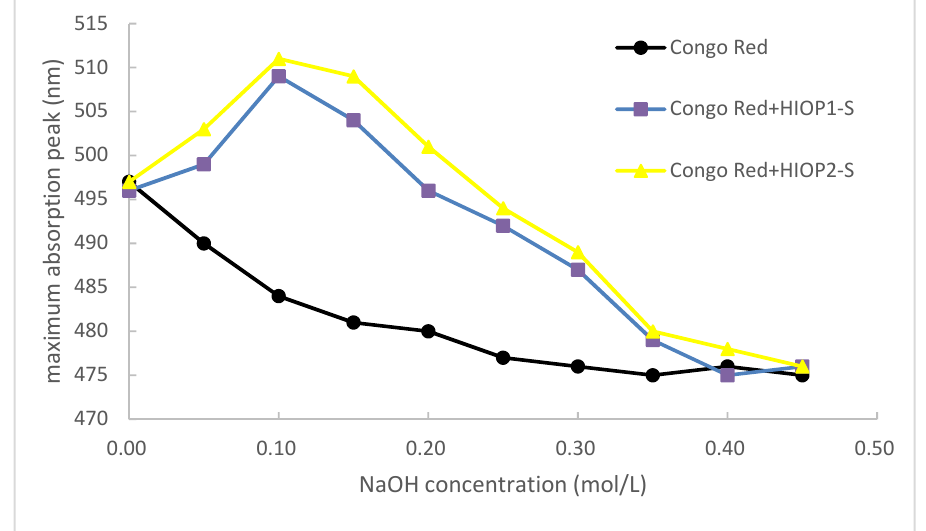
Figure 6. Congro Red test of HIOP1 ‐ S and HIOP2 ‐ S.